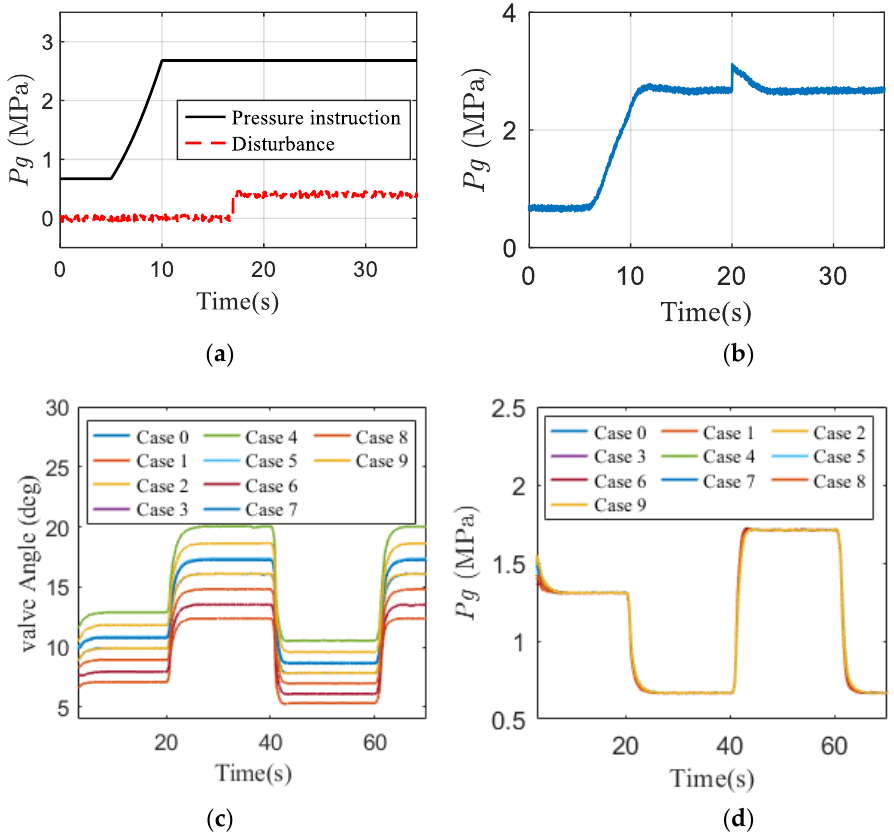
Figure 16. Response results ( a ) Pressure instruction and disturbance; ( b ) Pressure response; ( c ) Control input; ( d ) Gas flow response.